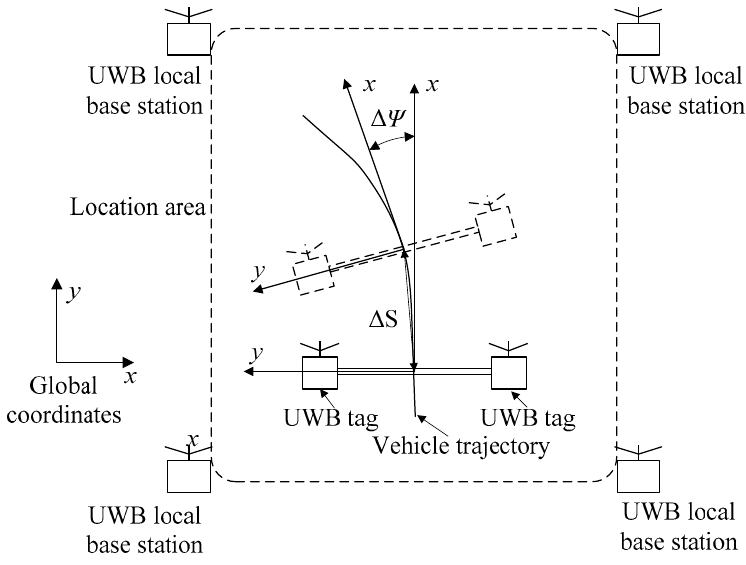
Figure 2. Vehicle pose estimation by UWB.